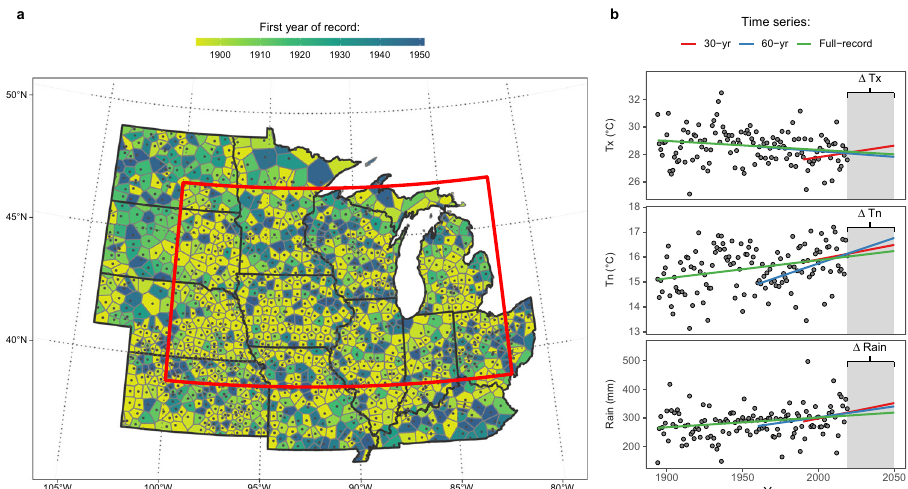
Fig. 1 Weather data and analytical approach. a Location of weather stations used. Daily observations for the summer growing season (JJA) were available from 1894 to 2019 for 485 stations, and 1951 to 2019 for all 1356 stations. Voronoi polygons indicate station spatial coverage. Red rectangle indicates the study area. b Example of the approach used to derive the historical summer climate trends and projections into 2050. Points indicate the average value across all weather stations. Lines indicate computed trends based on Sen ’ s slopes for three time